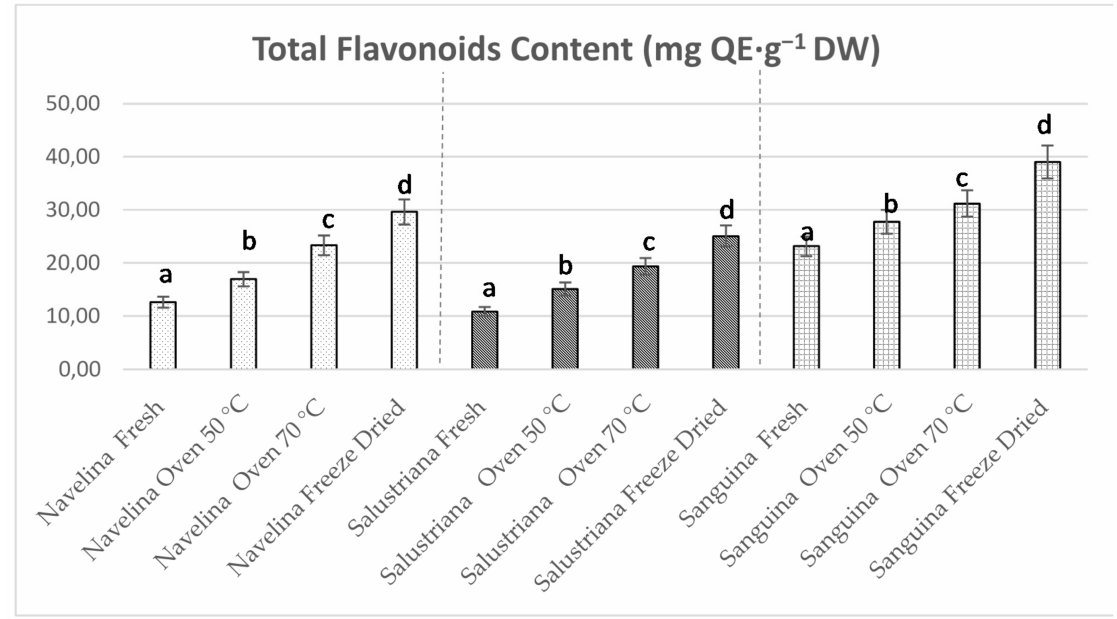
Figure 4. Total flavonoids contents (TFC) from pressurized extracts of Navelina, Salustriana, and Sanguina, both fresh and after drying treatments: oven-dried (50 ◦ C), oven-dried (70 ◦ C), and freeze-dried. QE–quercetin